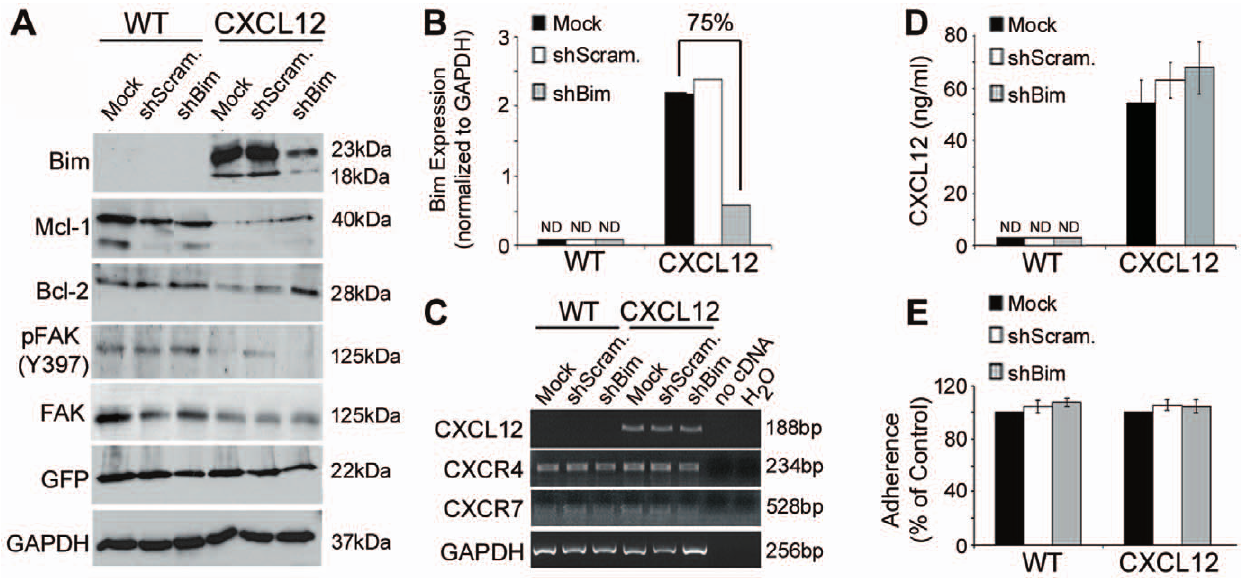
Figure 6. Bim depletion restores anti-apoptotic protein expression independent of changes in cellular adherence. (A) HCT116 cells were transduced by lentiviral particles encoding shRNA to create stable knockdown cell lines. Efficient knockdown of Bim levels after four days of non-adherent growth on poly-HEMA was confirmed by immunoblot analysis. Increased levels of Bcl-2 and Mcl-1 corresponded with Bim knockdown in CXCL12-expressing cells. Empty virus lacking shRNA and virus expressing a scrambled shRNA served as controls. (B) Densitometry analysis from 3 separate immunoblot analyses revealed a 75% knockdown of Bim protein levels in CXCL12 cells stably expressing Bim shRNA. (C) RT-PCR analysis confirmed CXCL12, CXCR4, and CXCR7 transcript levels were unchanged in Bim knockdown cells. (D) Enzyme-linked immunosorbent assay confirmed minimal alteration in CXCL12 secretion following lentiviral transduction. (E) HCT116 stable cell lines were grown to confluency and then serum- starved 6-days to determine if Bim depletion affected cellular adhesion. Crystal violet staining indicated adhesion was not significantly different between untransduced and RNAi-expressing cell lines. Values in D and E are mean 6 SD of three independent experiments.